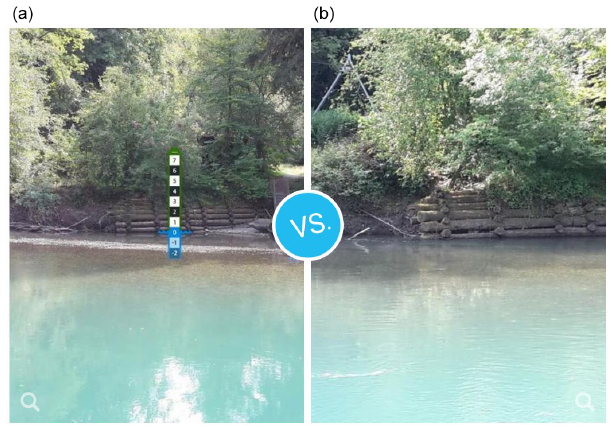
Figure 1. An example of a reference picture with the virtual staff gauge (a) and a picture from an observation at the same location at a later time (b) . The logs of the stream bank can be used as a reference to estimate the water level